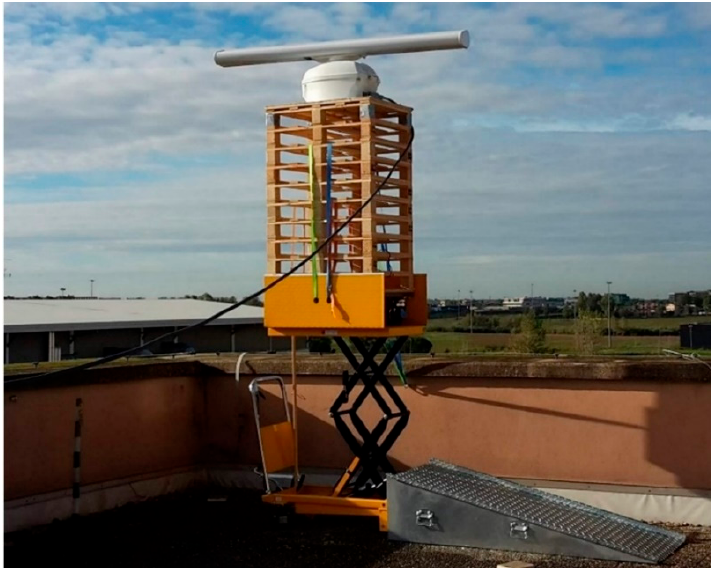
Figure 1. The Simrad/Navico SRT Radar and its lifter on the top of the Information Engineering building (Tor Vergata University).